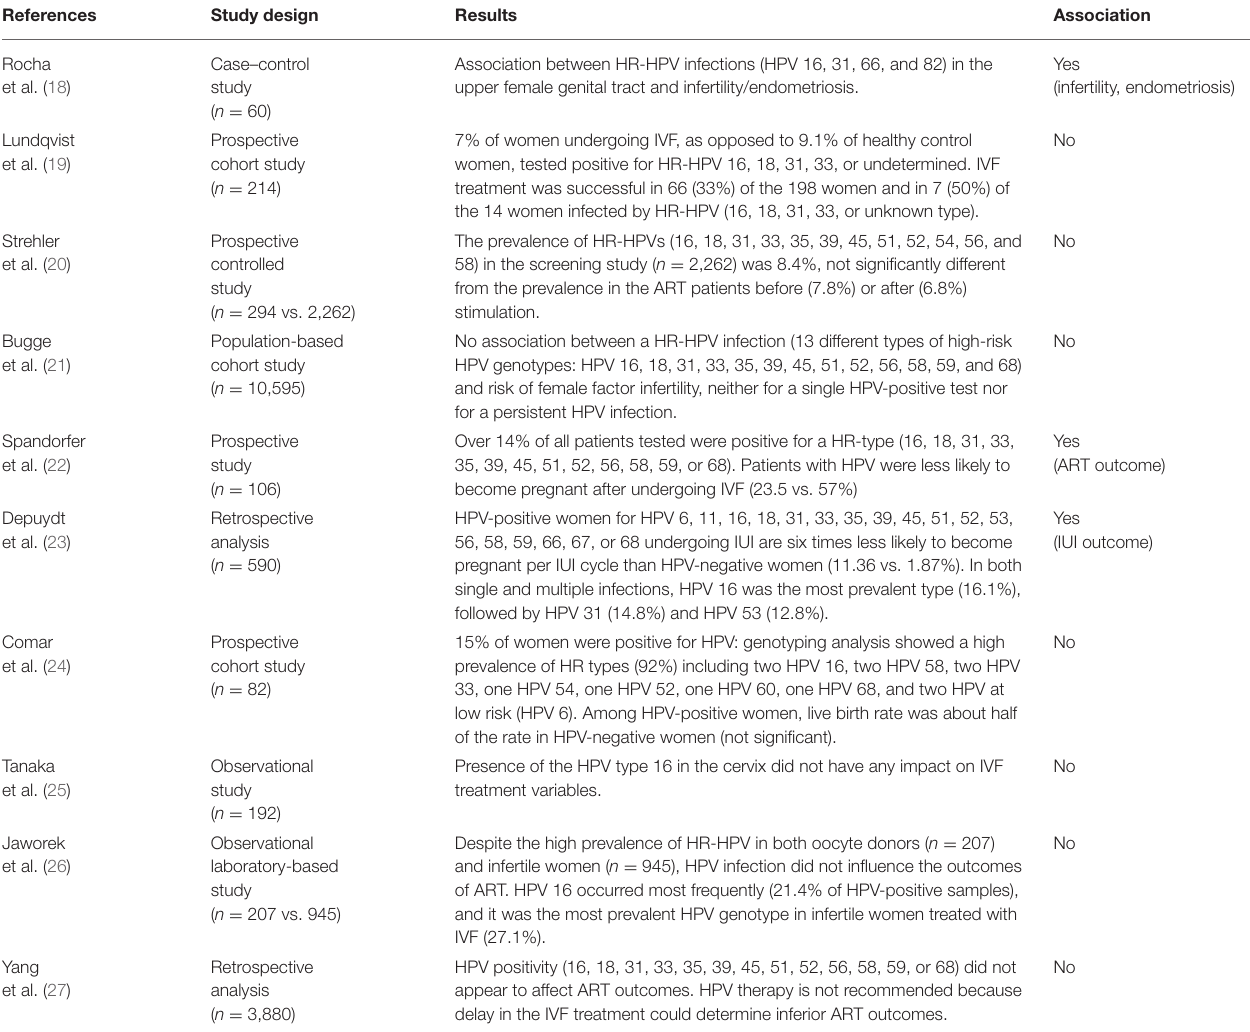
TABLE 1 | Literature regarding the effect of HPV included in the 9-valent vaccine on infertility and assisted reproductive